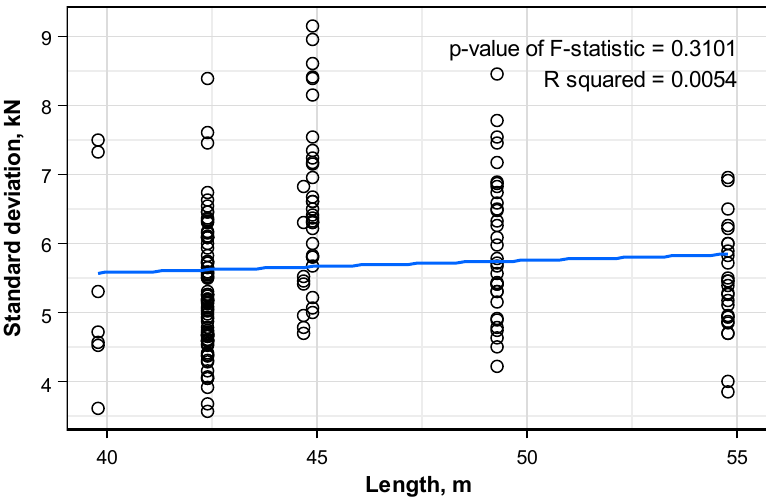
Figure 11. Distribution pattern of the standard deviation of the prestress force per anchor head according to the structure length.